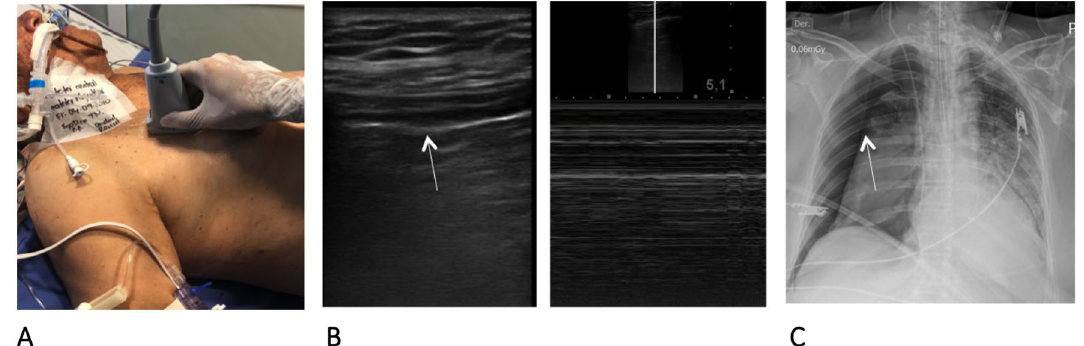
Fig. 1 A Evaluation of the presence of pneumothorax with a high‑frequency linear transducer (13 MHz) B. Pneumothorax was diagnosed due to the absence of pleural sliding (arrow) and the barcode sign in M‑mode C. Chest radiograph confirming the presence of pneumothorax (arrow)